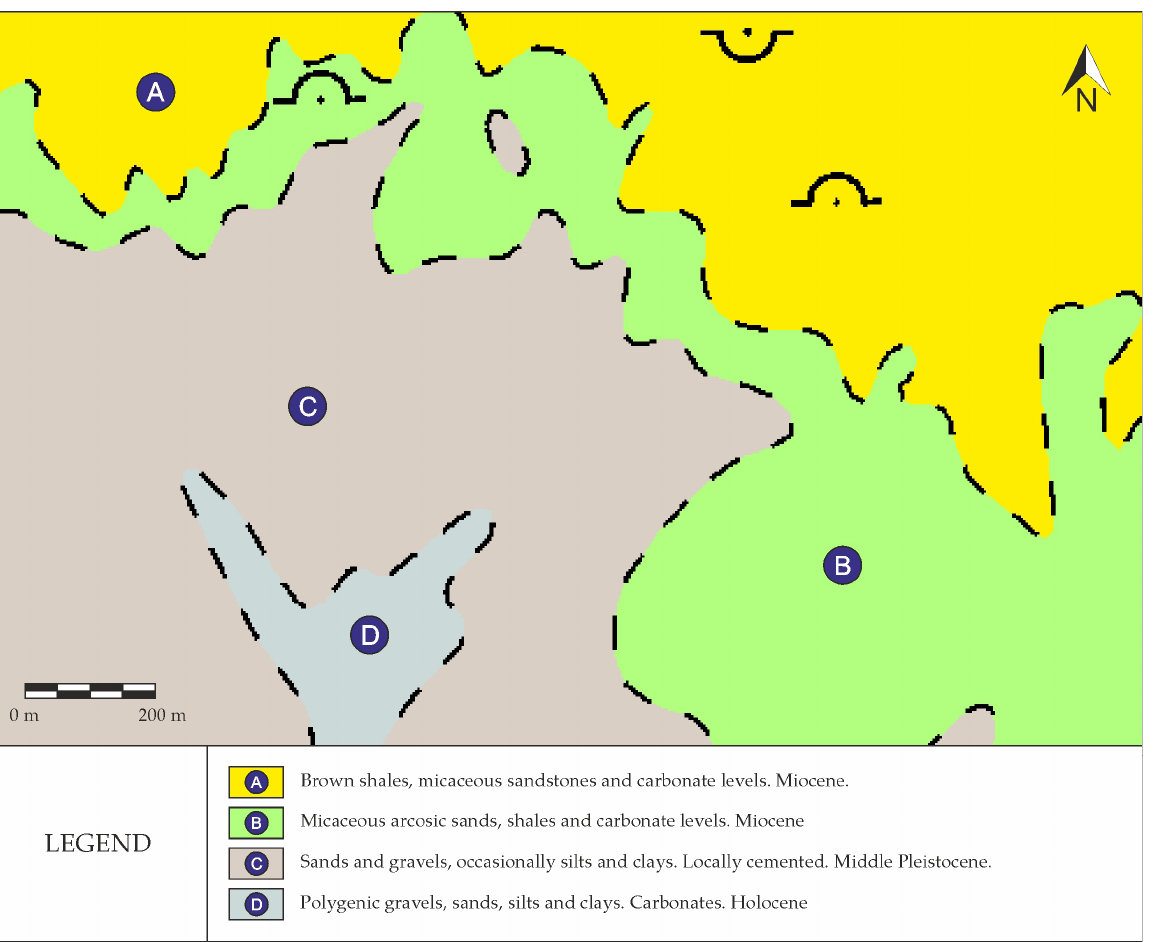
Figure 3. Digital continuous geological map at a scale of 1:50,000, zone 2400 (Tajo-Mancha Basin). From the general geomorphologic point of view, the reliefs of the Henares and Jarama Rivers in terraces stand out [50].